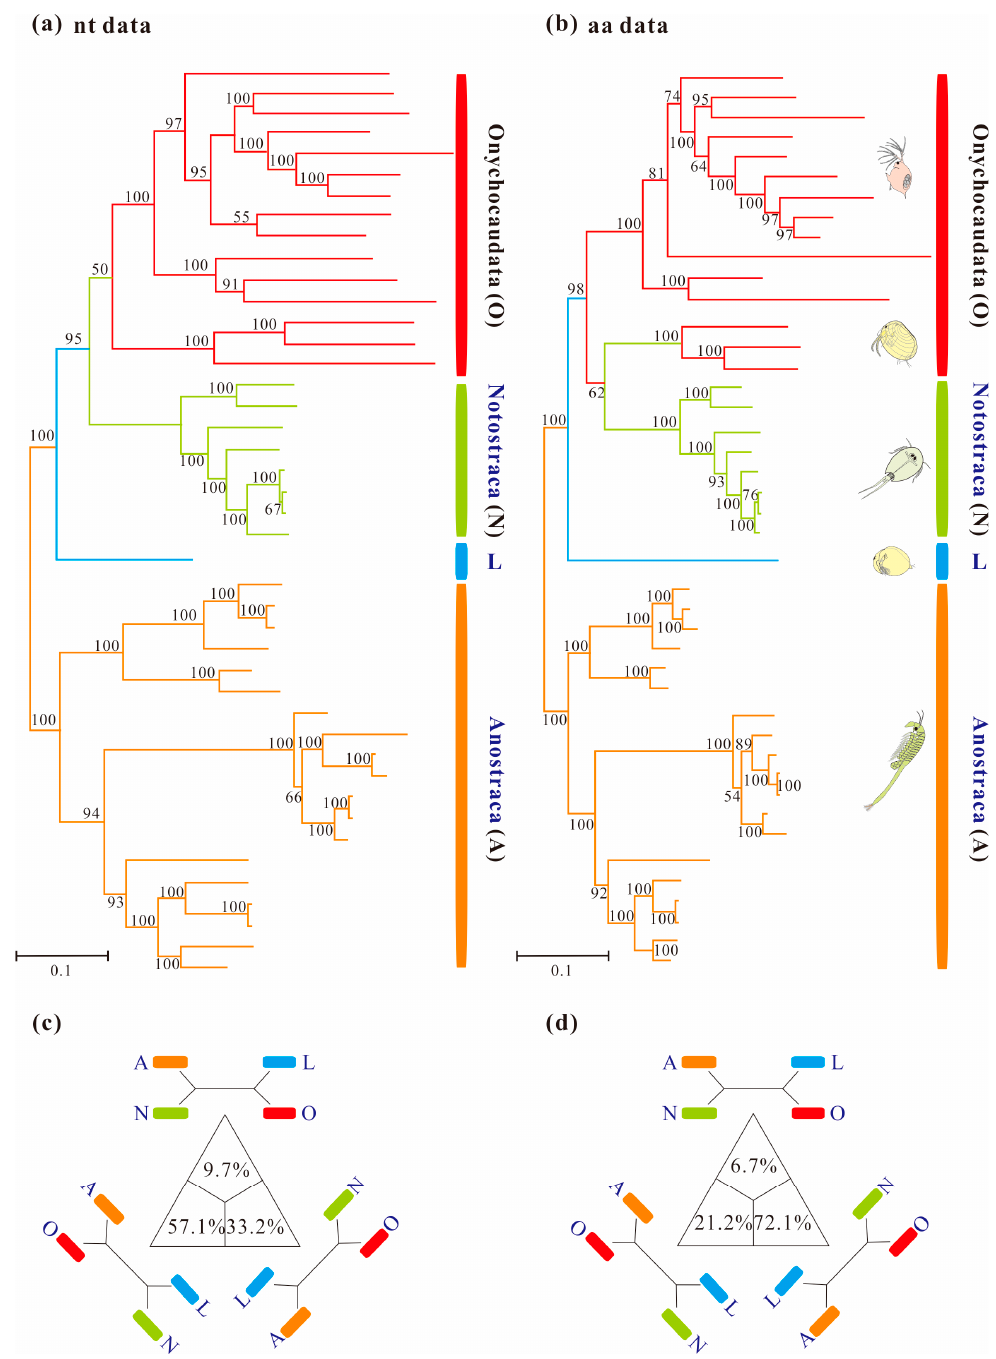
Figure 1. Maximum-likelihood phylograms of Branchiopoda based on concatenation of 13 mito- chondrial genes under site-homogeneous models obtained with RAxML: ( a ) PCG12 matrix and ( b ) PAA matrix. Major groups are labeled and each group is indicated with a representative line drawing. Nodal supports are bootstrap values. The trees of Branchiopoda between the nucleotide and amino acid datasets exhibit incongruence by the monophyly of Onychocaudata. ( c ) and ( d ) are results based on the PCG12 and PAA datasets respectively using the four-cluster likelihood mapping analyses. For each matrix, the sequences are divided into four clades: ( a ) Anostraca; ( b ) Notostraca; ( c ) Laevicaudata; ( d ) Onychocaudata. The corners of the triangles represent the three alternative